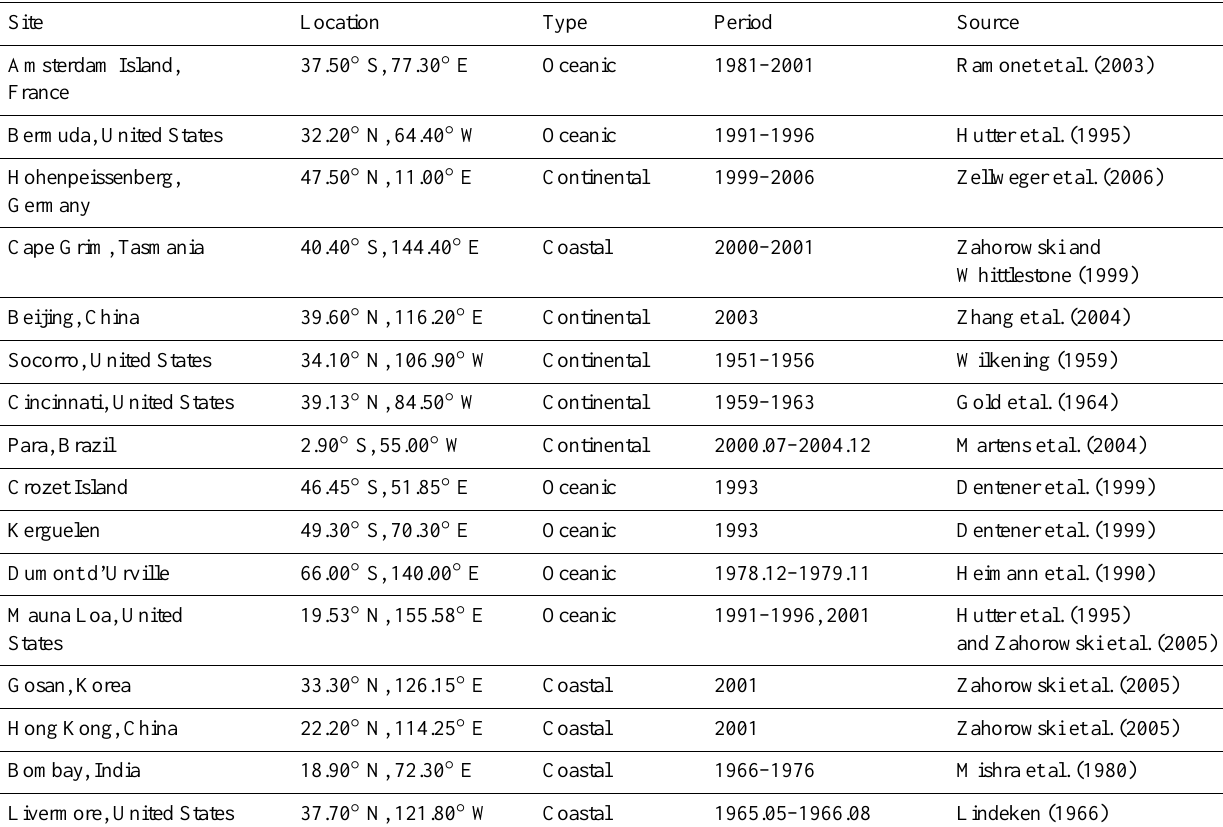
Table 4. Detailed information about the surface radon measurements used in this